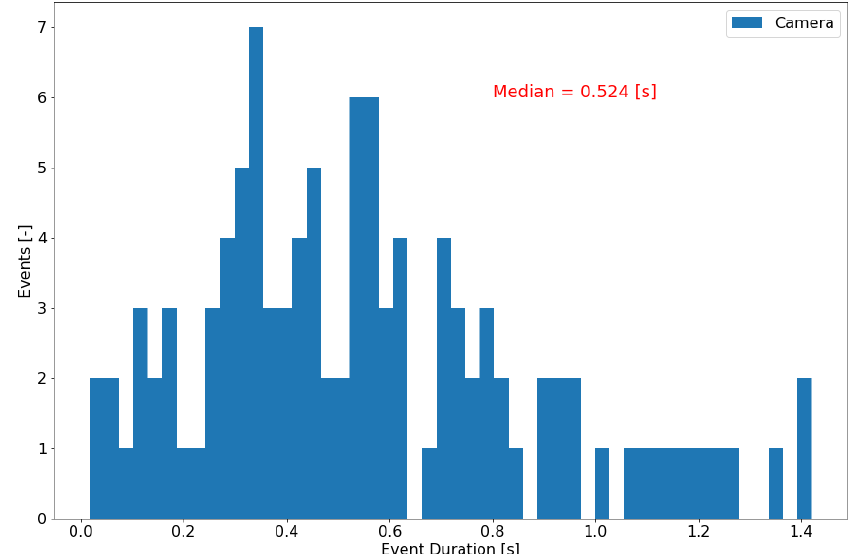
Figure 19. A histogram of the observed duration of lightning events. The histogram is based on data captured by the high-speed cameras.